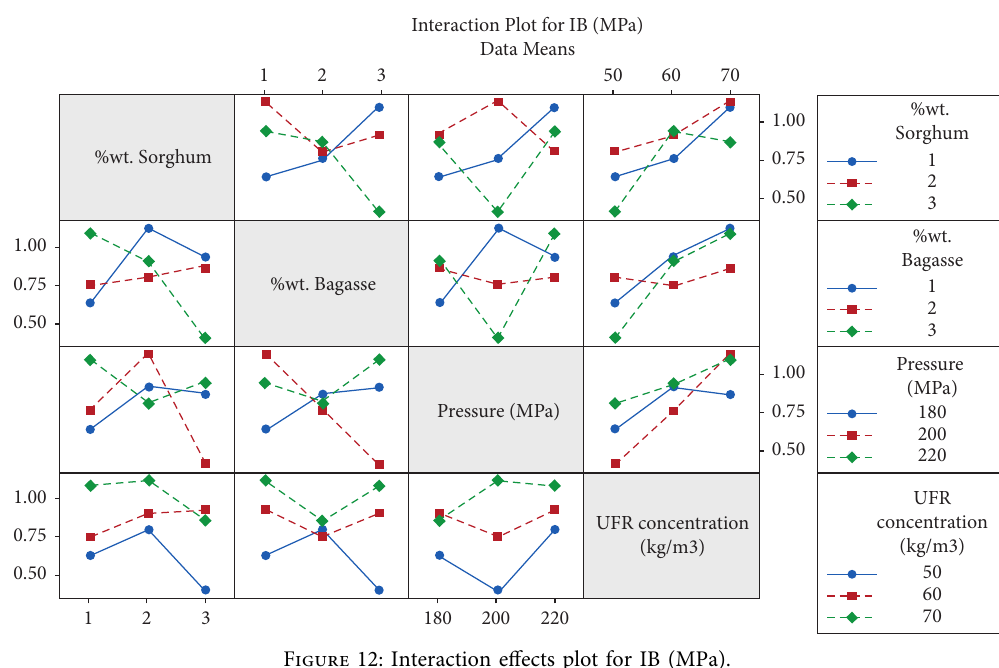
Figure 12: Interaction effects plot for IB (MPa).